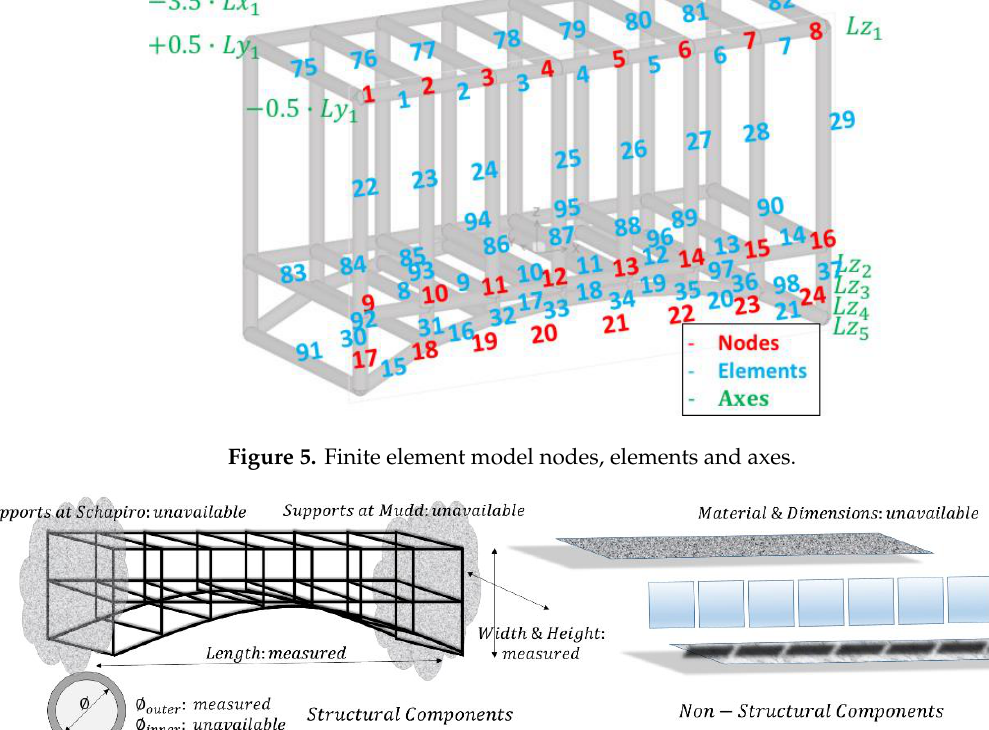
Figure 6. Finite element modeling uncertainties.